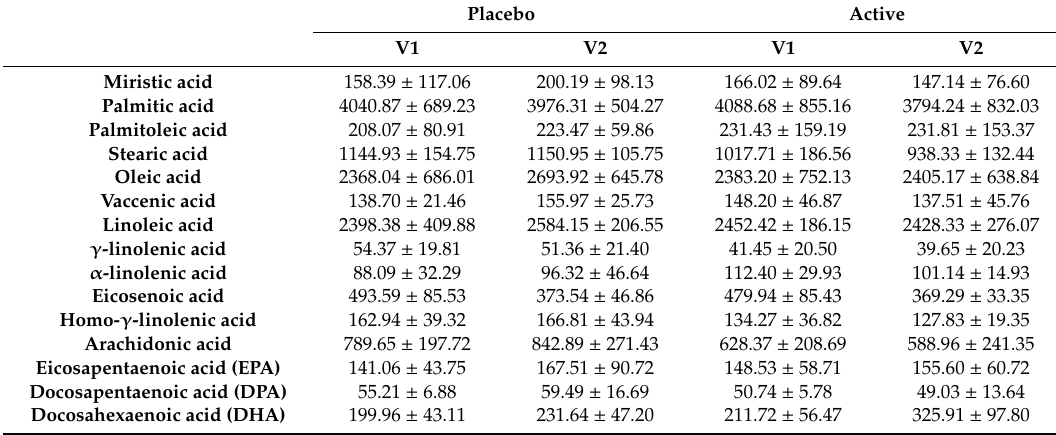
Table A2. Concentration of fatty acids (mean ± SD, µ mol / L) of plasma total